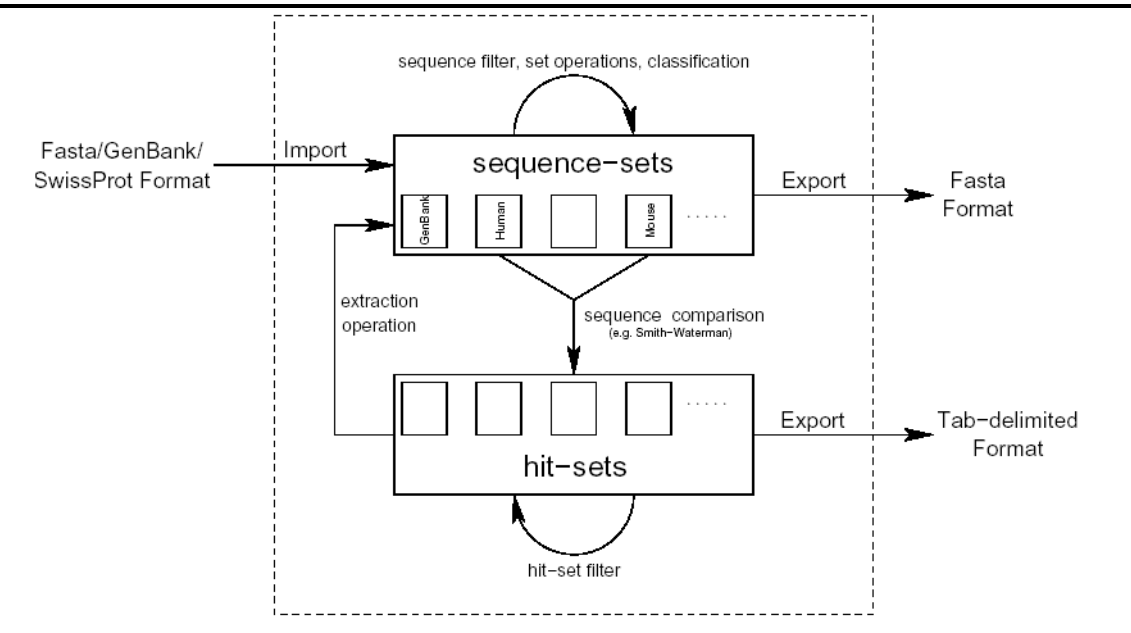
Figure 2: The set-oriented concept: Basic data structures and their compositionality